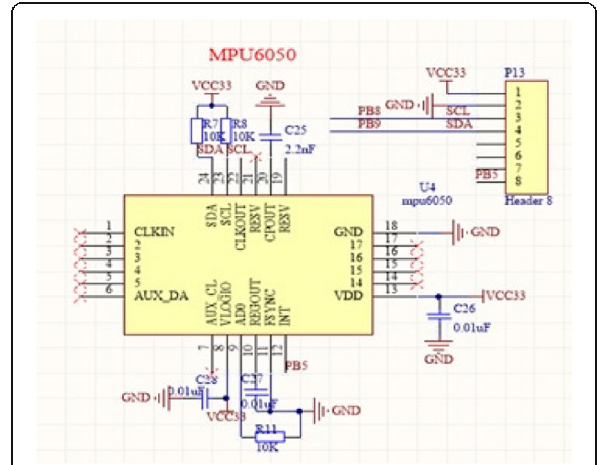
Fig. 24 The circuit of the gyroscope